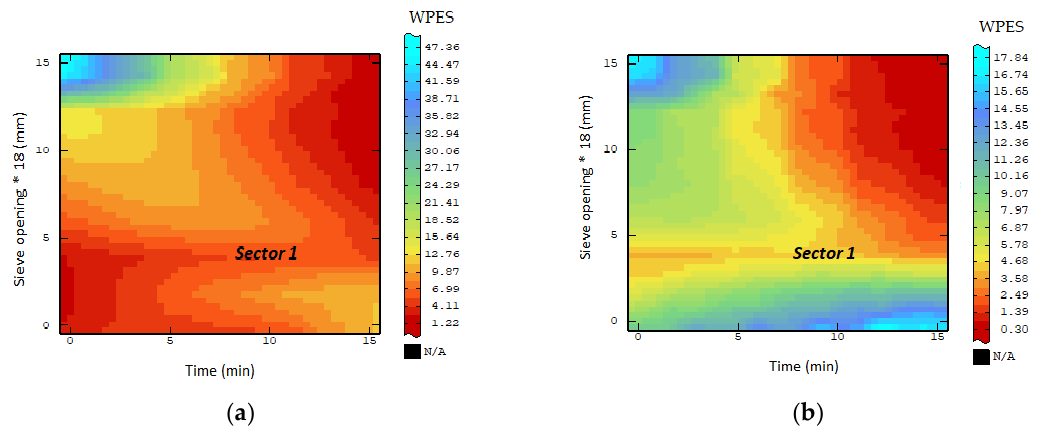
Figure 6. Spatial interpolation through a geostatistical analysis: ( a ) LGP-1 for ore-A; ( b ) LGP-1 for ore-B.